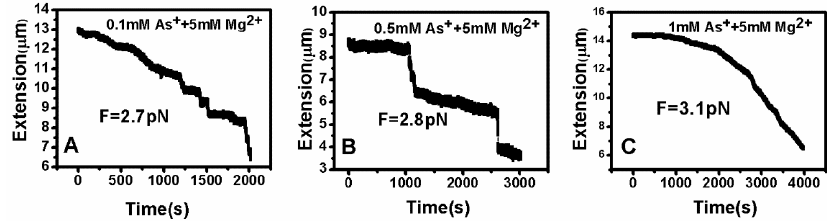
Figure 6. DNA extension–time curves when ( A ) contracting and ( B ) stretching at various Ph 4 As + concentrations.